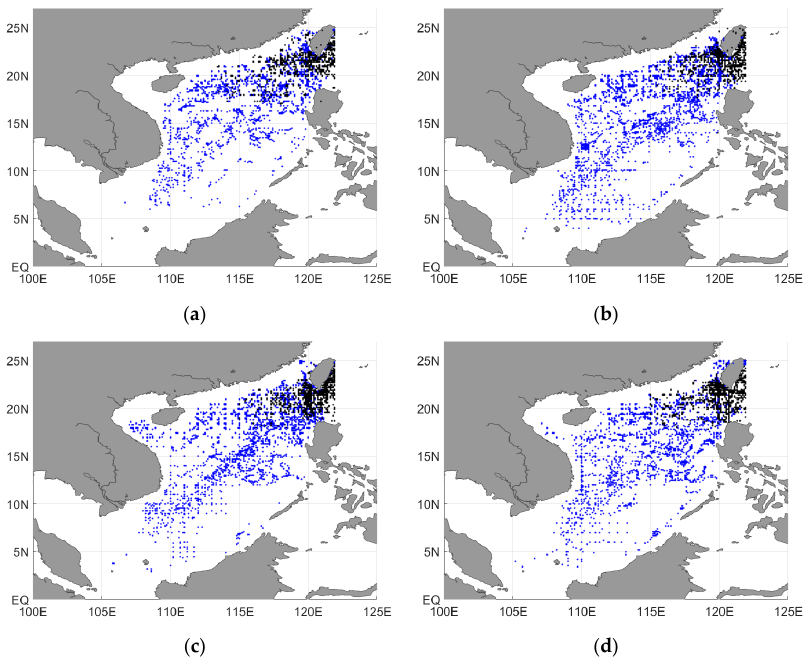
Figure 4. Subsurface water mass division. ( a ) Winter, ( b ) spring, ( c ) summer, and ( d ) autumn. Blue scatter: the SCS subsurface water (U); black scatter: the Kuroshio subsurface water (KU)